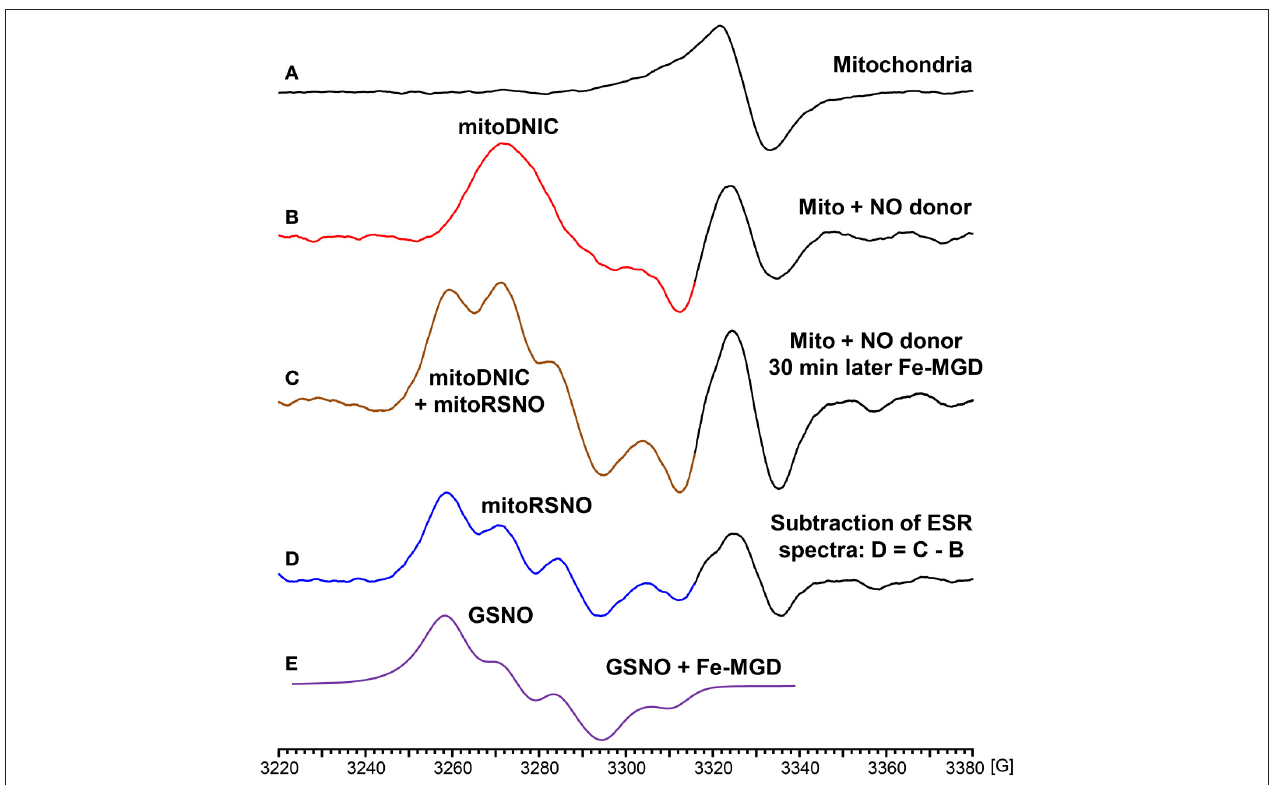
FIGURE 4 | Formation of dinitrosyl iron complexes and nitrosothiols in nitric oxide-treated mitochondria. Mitochondria were isolated from mouse kidney (10 mg/ml) and incubated in respiration media at 25 ◦ C for 30 with vehicle or NO-donor MAHMA Nonoate (10 µ M). Then mitochondria were snap-frozen in liquid nitrogen for Electron Spin Resonance (ESR) studies. (A) Untreated mitochondria; (B) NO-donor treated mitochondria; (C) Lysed NO-donor treated mitochondria with 0.1mM Fe(MGD) 2 complex; (D) Subtraction of dinitrosyl iron complex ESR spectrum (B) from spectrum (C) revealed the presence of mitochondrial nitrosothiols (mitoRSNO); (E) Reference ESR spectrum of 2 µ M GSNO plus 0.1mM Fe(MGD) 2 . The average integral amount of mitochondrial dinitrosyl iron complexes (mitoDNIC) and nitrosothiols ESR signal is 2 µ M (standard error < 15%). Figure shows typical ESR spectra of four independent